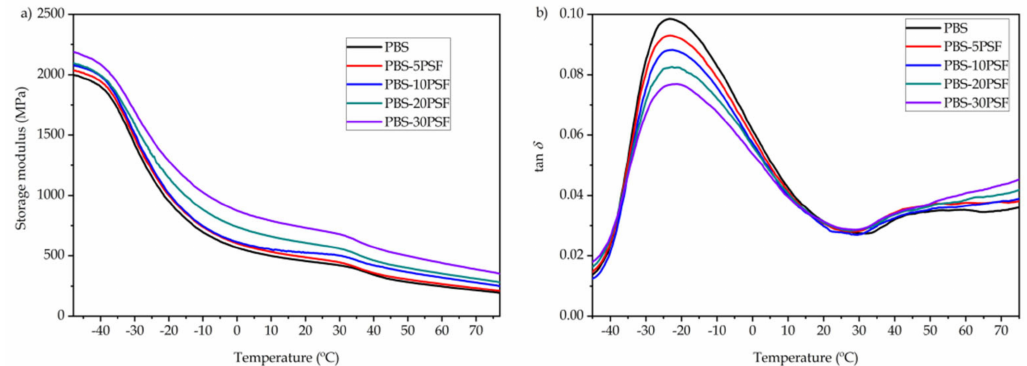
Figure 8. Evolution as function of the temperature of the storage modulus ( a ) and dynamic damping factor ( tan δ ) ( b ) of the injection-molded pieces of poly(butylene succinate) (PBS)/pistachio shell flour (PSF) compatibilized with poly(butylene succinate) grafted with maleic anhydride (PBS- g